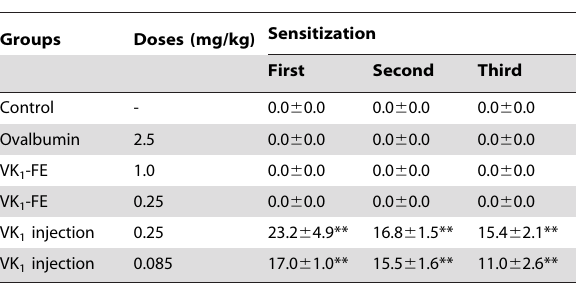
Table 5. The scores of the symptoms shown by the dogs after three sensitizations with vitamin K 1 (VK 1 ) injection and vitamin K 1 -fat emulsion (VK 1 -FE).